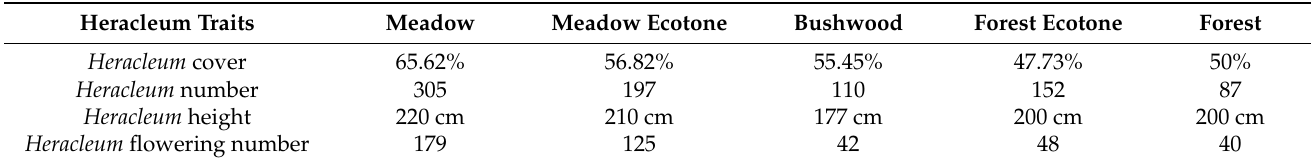
Table 2. Caucasian hogweeds’ average traits from the third field visit determined within 50 m radius circle plots separately from each of the five habitat